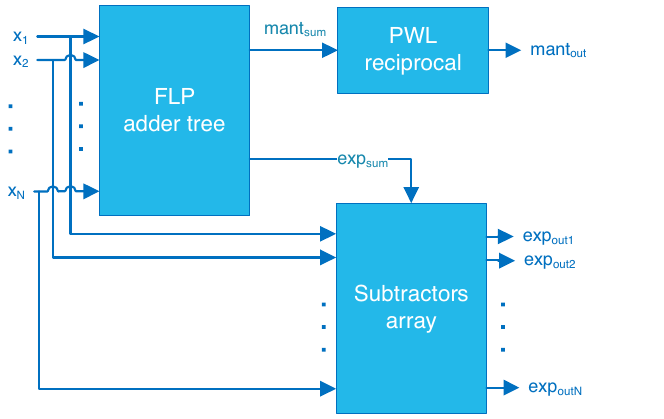
Figure 2. Pseudo-softmax function top level